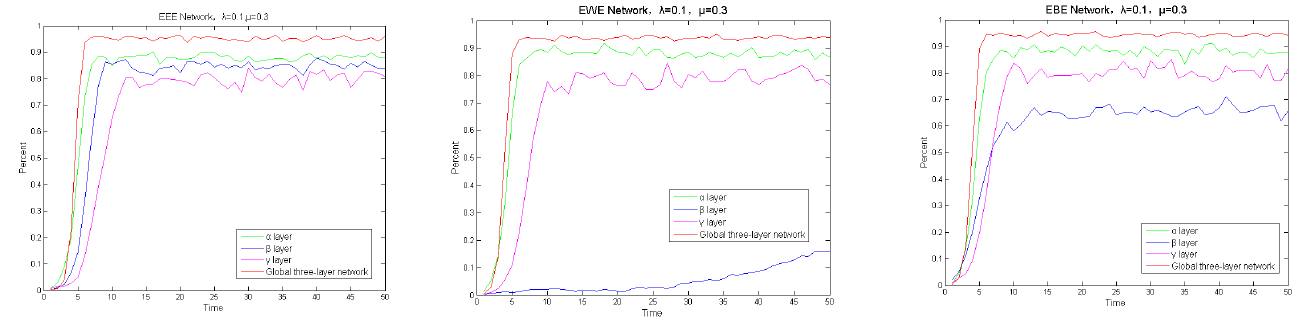
Figure 4. Spread threshold comparisons of the global and single layer of three-layer complex net- works.